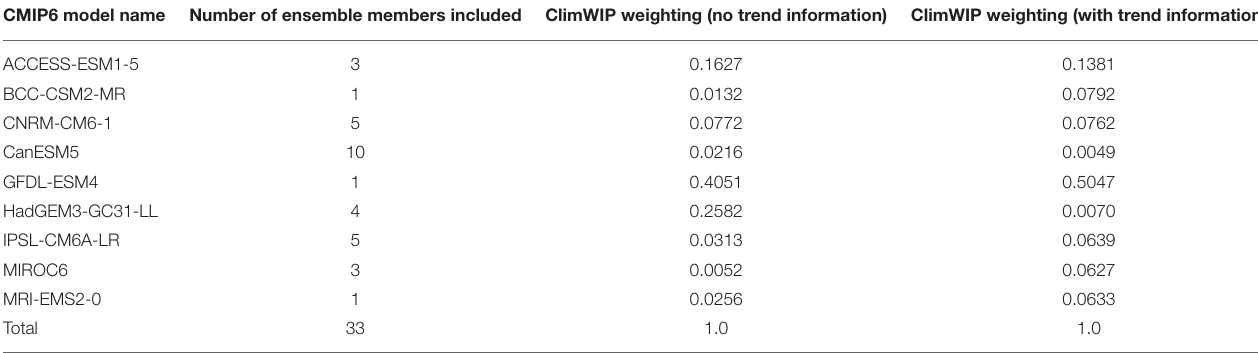
TABLE 1 | List of the CMIP6 models used in the ASK-ClimWIP constraining intercomparison pilot study (restricting to models with individual forcing simulations available and normalizing weights to sum to unity for these relative to those shown in Figure 3